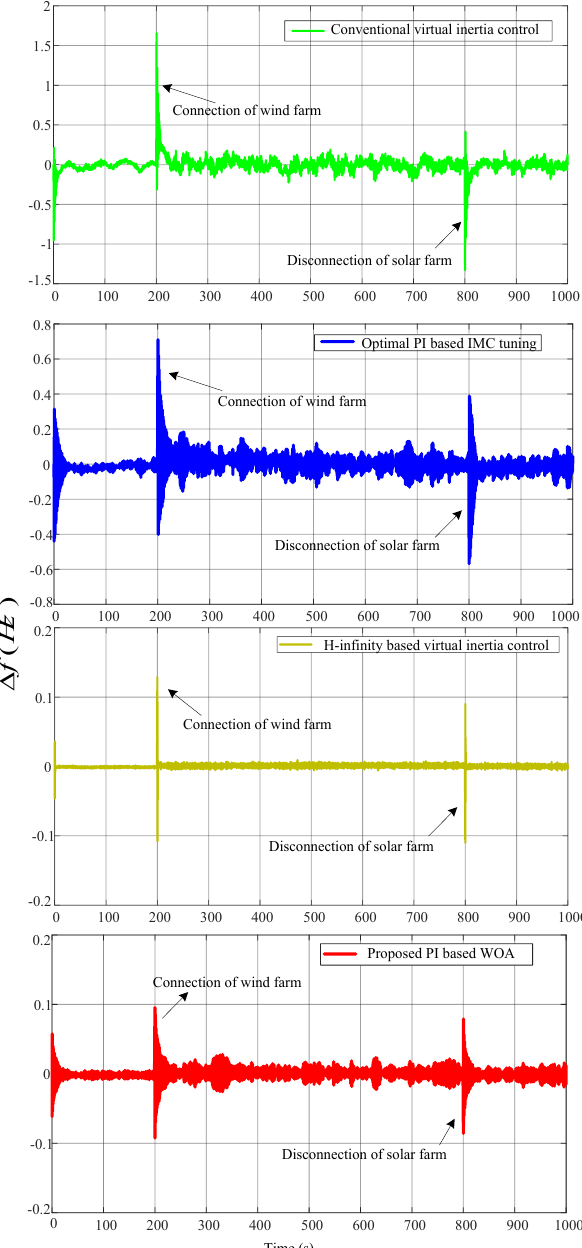
Figure 10. Frequency response under low system inertia.